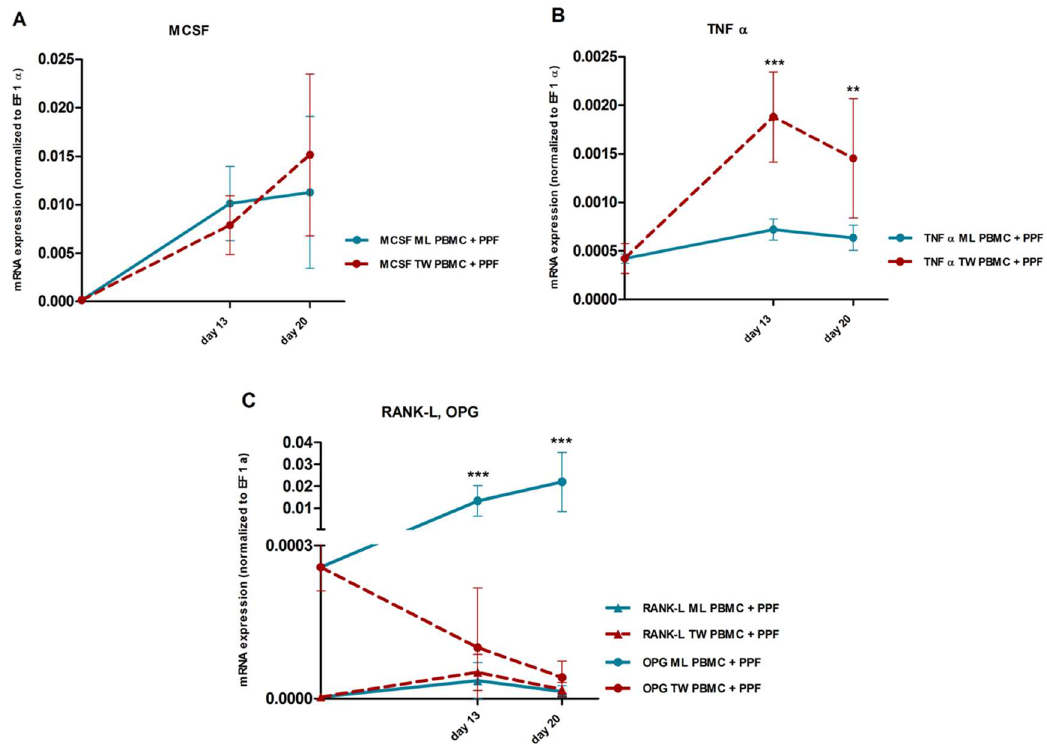
Figure 5. mRNA expression of PPF/PBMC co-cultures in monolayer and transwell over time. Relative mRNA expression (mean and standard deviation, normalized to housekeeping gene EF 1 α) of MCSF ( A ), TNFα ( B ), RANK-L, and OPG ( C ) over time (day 0, 13, 20) of co-cultures of PBMCs and PPFs in monolayer (ML, n = 10) and transwell (TW, n = 10) culture systems. Significance of differences between monolayer and transwell co-cultures is indicated with * ( p ≤ 0,05), ** ( p ≤ 0.01), *** ( p ≤ 0.001).